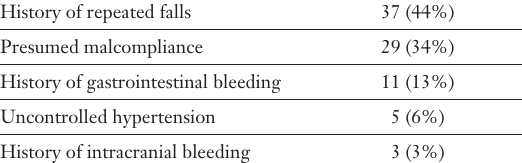
Table 3 Contraindication to anticoagulation in 85